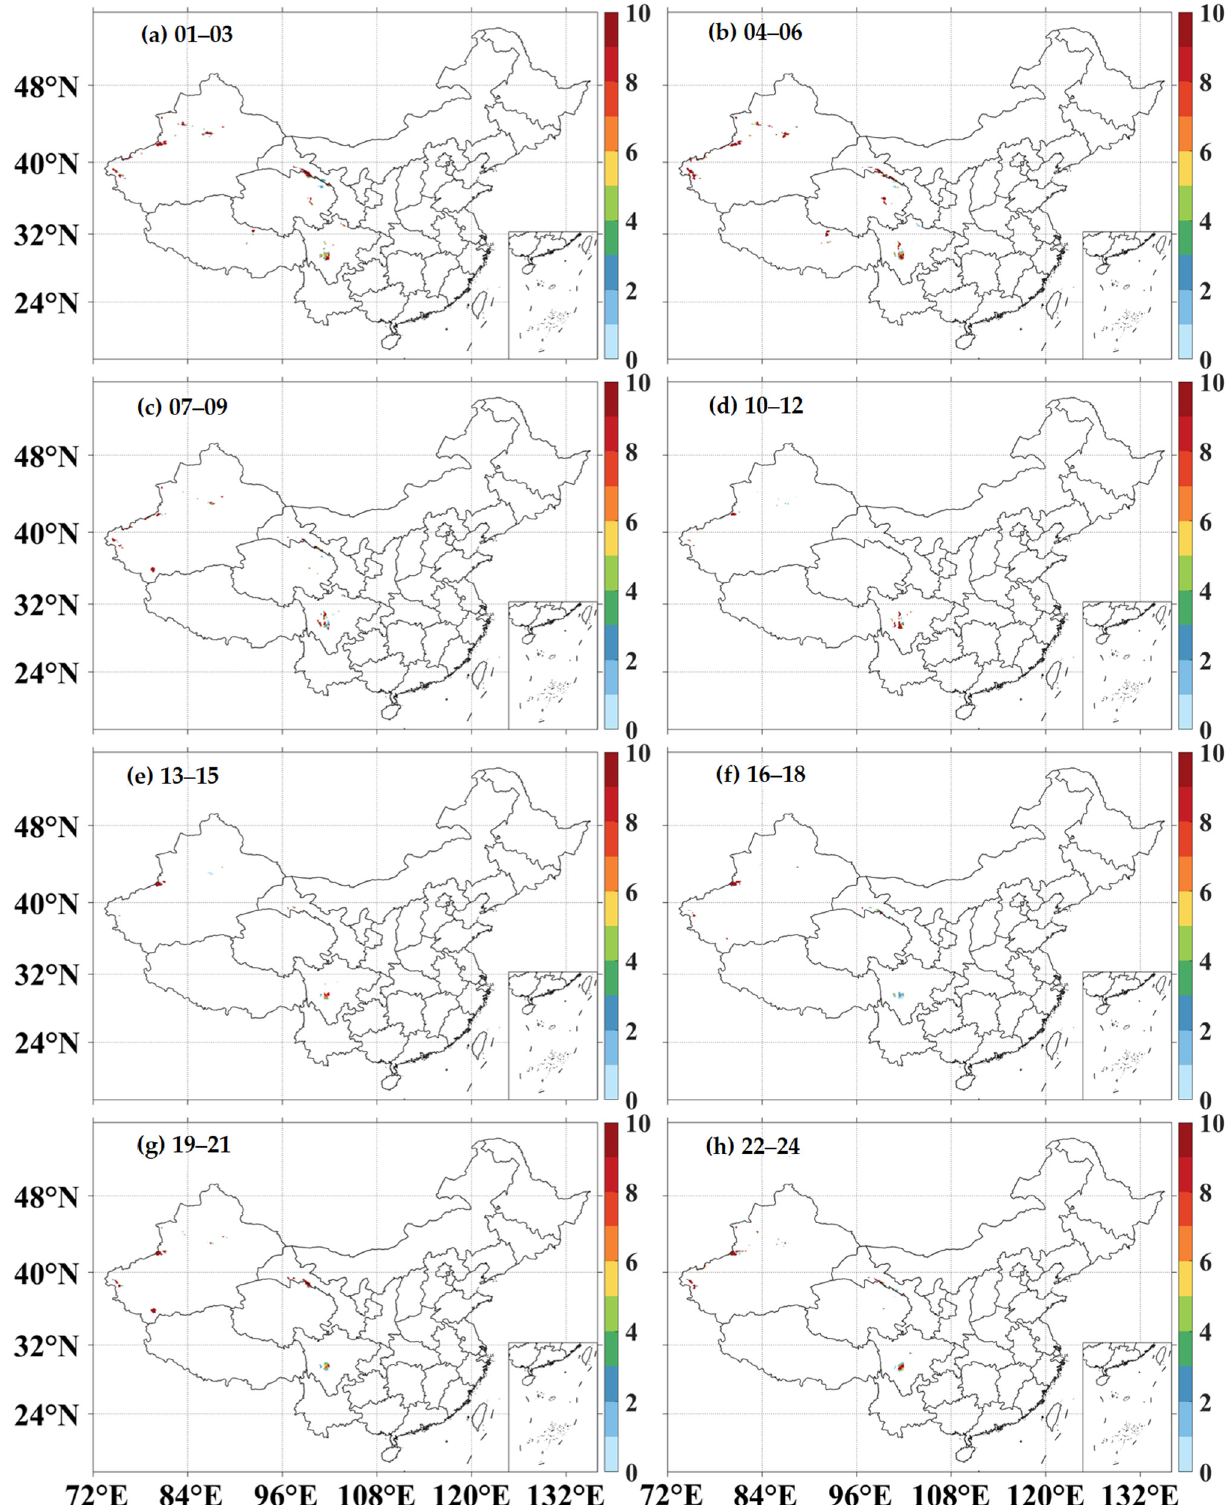
Figure 16. Diurnal variation of frequency (%) distribution of snow for period LST 01–03, 04–06, 07–09, 10–12, 13–15, 16–18, 19–21, and 22–24 in August from 2018 to 2021. In July, snowfall occurs significantly lower than in June, and its frequency is extremely low. In this period, snowfall primarily occurs in the regions south of the Tianshan